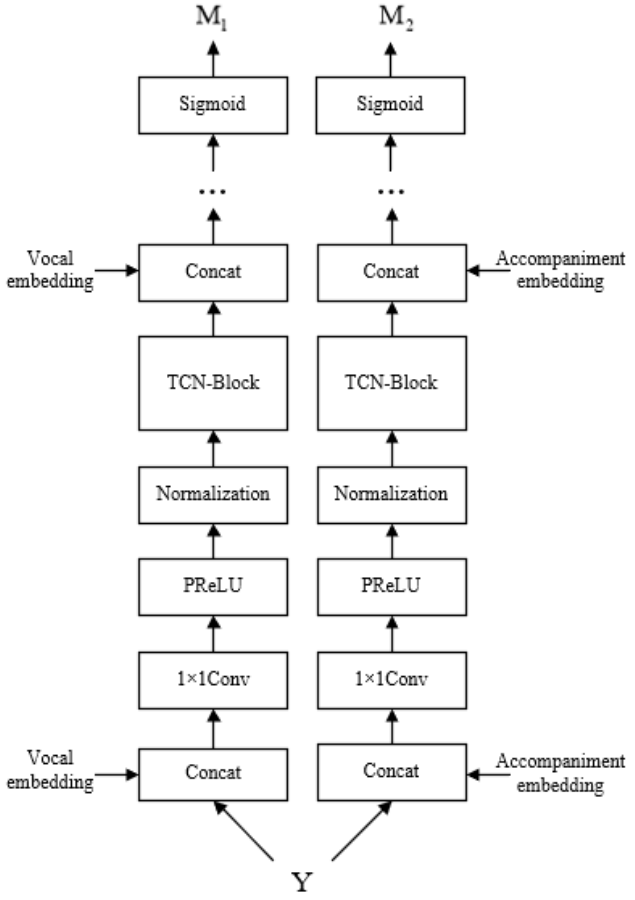
Figure 4. Internal structure diagram of the separator.